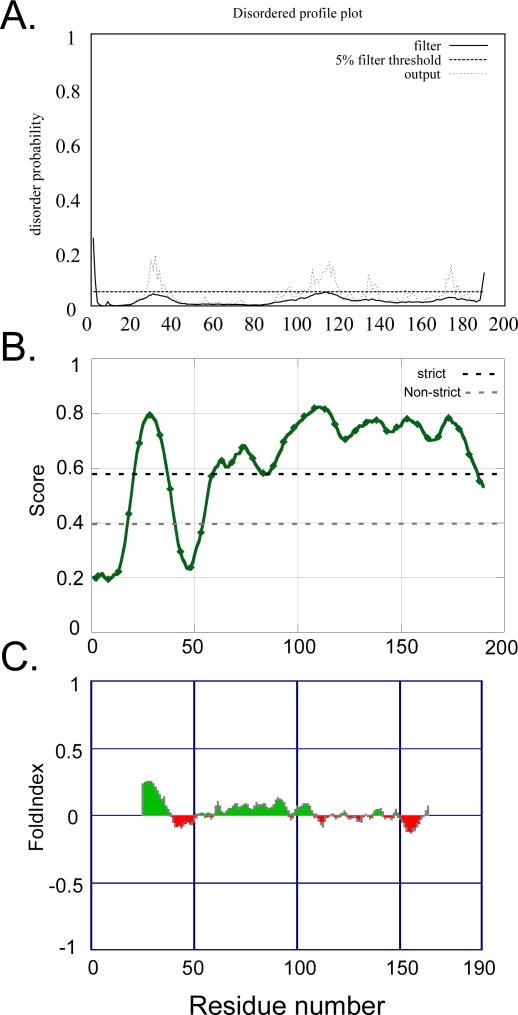
Different Prediction Method Outputs for Kappa-Casein PrecursorKappa-casein precursor has been shown to be unstructured by different experiments [50]. Despite its low content in predicted helices and strands, not all prediction methods identify it as unstructured. We compared outputs of DISOPRED2 (A), NORSnet (B), and FoldIndex (C) for this protein. For DISOPRED2 and NORSnet, higher values indicate unstructured regions; for FoldIndex, low values indicate unstructured regions (red). Note that FoldIndex and DISOPRED2 do not use any explicit information about secondary structure. DISOPRED2 disorder probability, however, is somewhat correlated with coil predictions (Figure S1). DISOPRED2 was not able to distinguish these loops from structured loops. Only NORSnet clearly picked up the strong signal for unstructured regions for most of the protein.